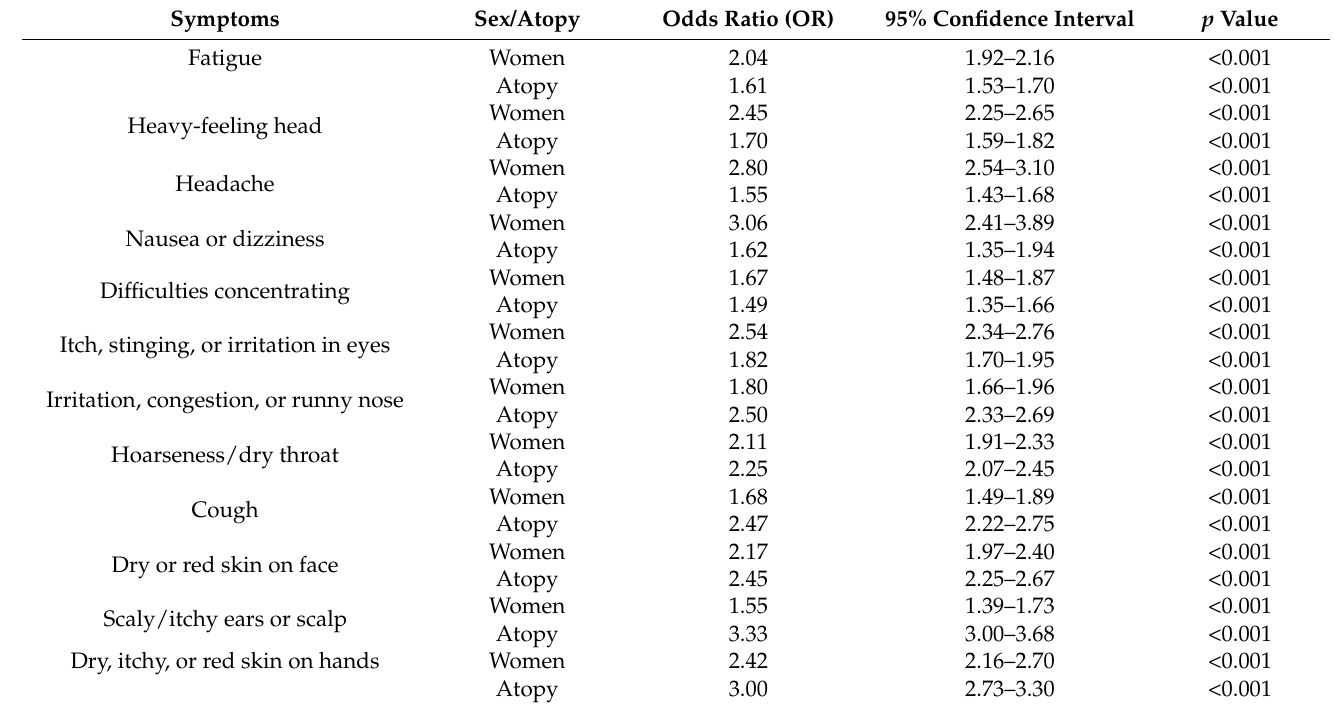
Table 3. Logistic regression analyses of the effect of sex, i.e., women vs. men, and atopy on reporting of symptoms (“Yes often”) in office